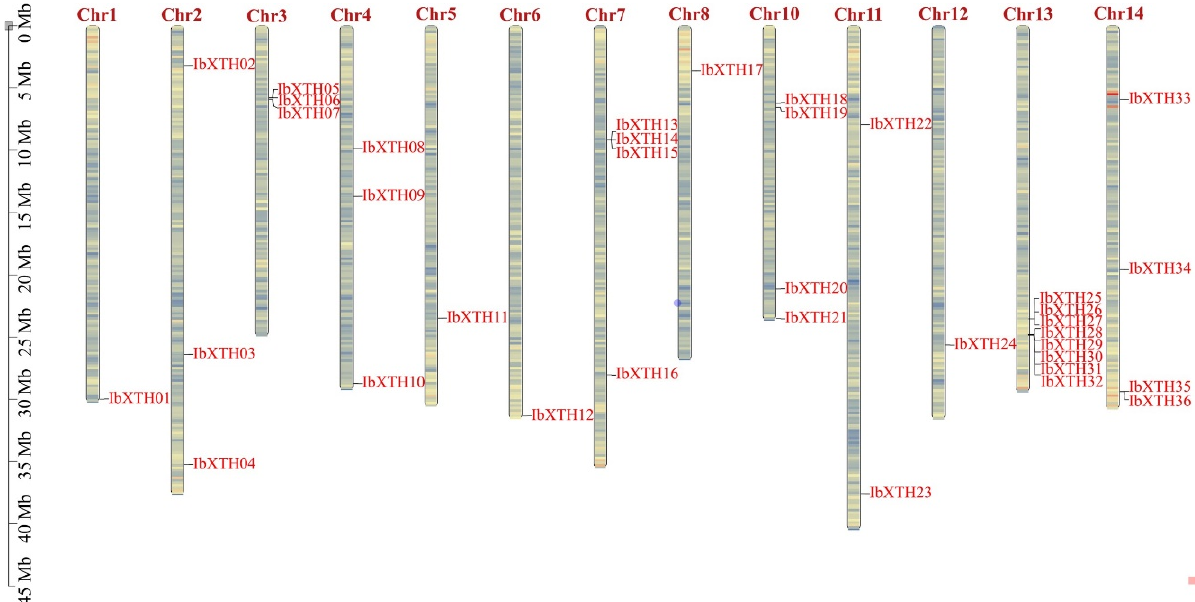
Figure 1. Gene location of the sweet potato XTHs , which were designated based on their chromosomal locations. The map was constructed and visualized by TBtools.